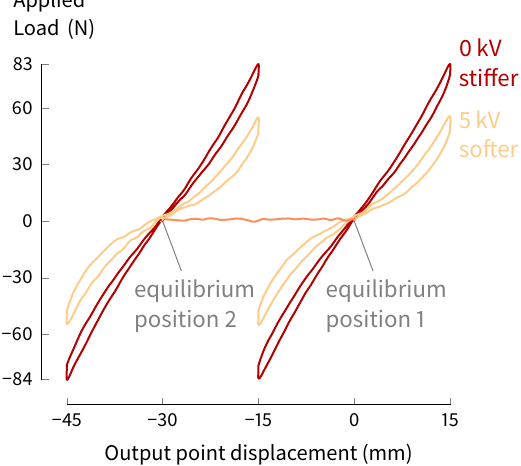
Figure 5. Our DET VSA can independently modulate its stiffness and equilibrium position as seen in this plot of the load applied to the DET VSA and its output point displacement. It has the same range of stiffnesses after the actuation motor shifted the equilibrium position from equilibrium position 1 to equilibrium position